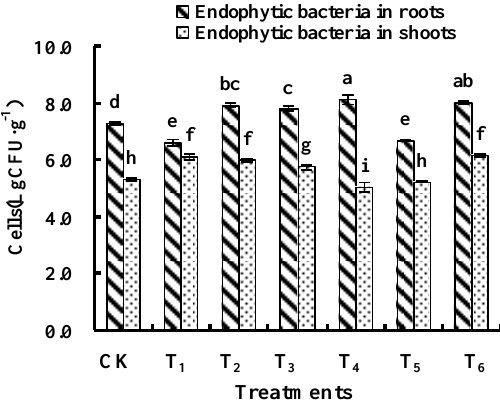
Figure 1. Effects of polycyclic aromatic hydrocarbons (PAHs) on the numbers of cultivable endophytic bacteria in the seedlings. Same lowercase letters indicate a lack of statistically significant difference between treatments ( p < 0.05). Table 2. The concentrations of PAHs in the plant tissues (mg·kg −1 ).